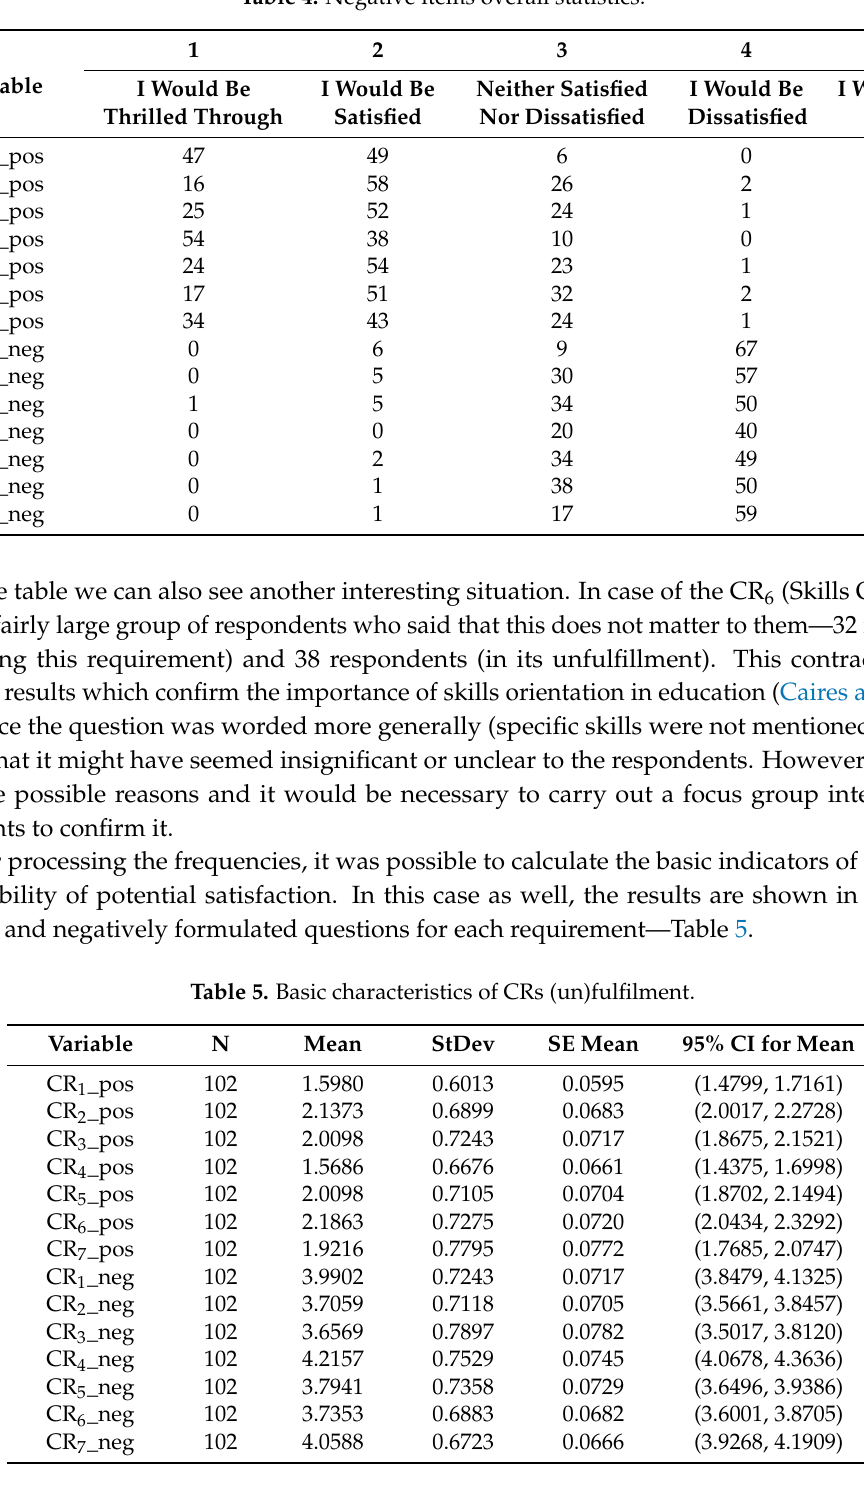
Table 4. Negative items overall statistics.